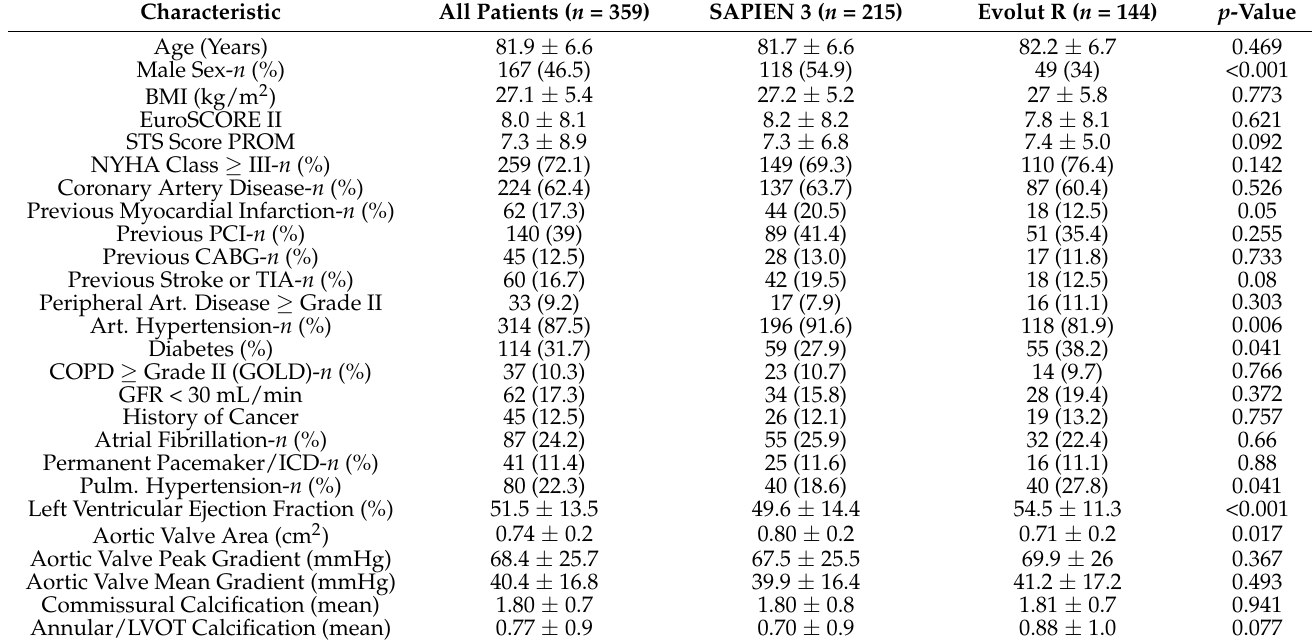
Table 1. Baseline Patient